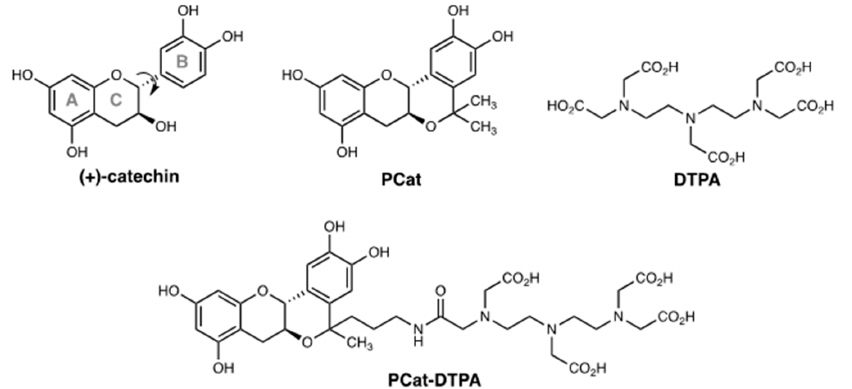
Figure 1. Structures of (+)-catechin, PCat, DTPA, and